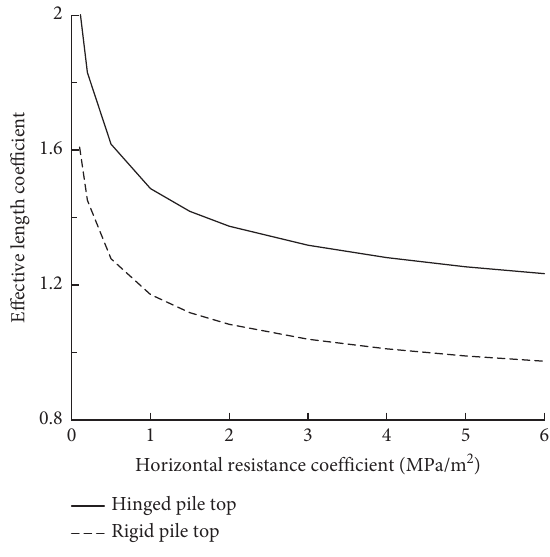
Figure 9: Effective length coefficient-pile body